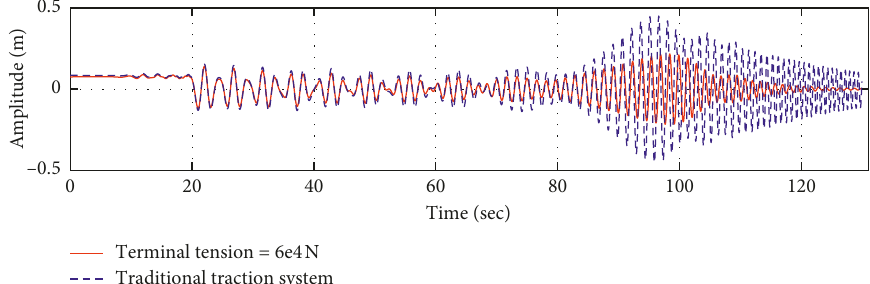
Figure 14: Comparison of the longitudinal vibrations at the conveyance between a traction system with a terminal tension of 6 × 10 4 N (red line) and a traditional traction system (blue line).